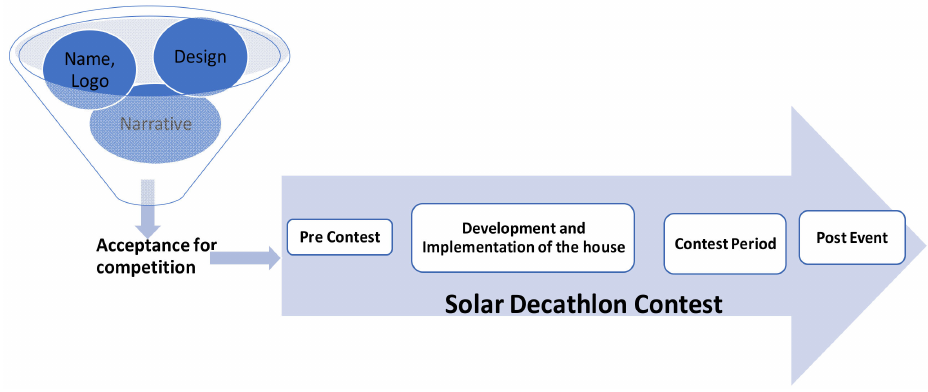
Figure 2. Innovation from the perspective of time during the SD